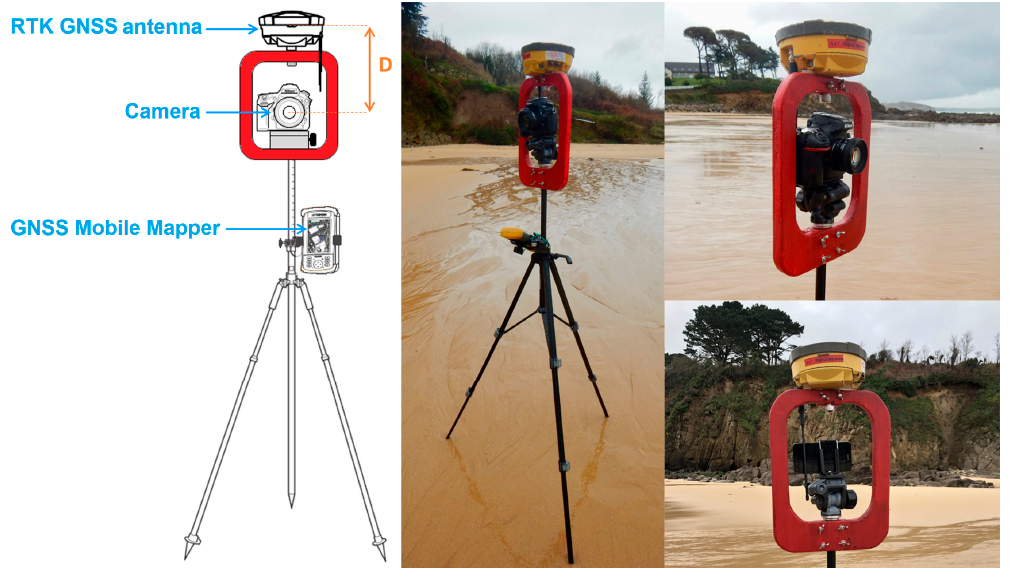
Figure 2. Measurement system developed for the Real Time Kinematic (RTK) Global Navigation Satellite System (GNSS)-assisted terrestrial Structure-from-Motion (SfM) photogrammetry method (equipped with the Nikon D800 Reflex camera or with the Huawei Y5 Smartphone).